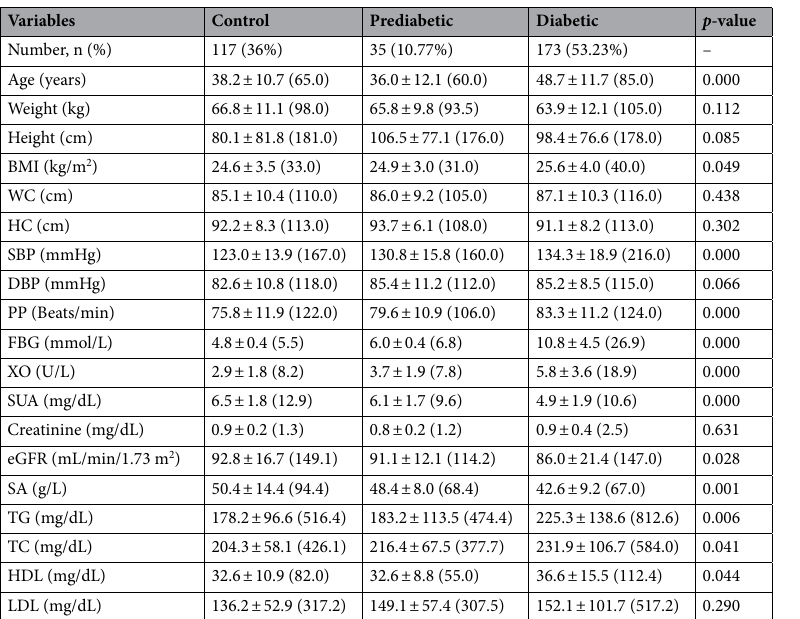
Table 2. Baseline characteristics in control, prediabetic, and diabetic groups. Values are presented as mean ± SD with maximum values in parentheses. p-values are given for differences in control, prediabetic, and diabetic groups. p-values are obtained from one-way ANOVA.